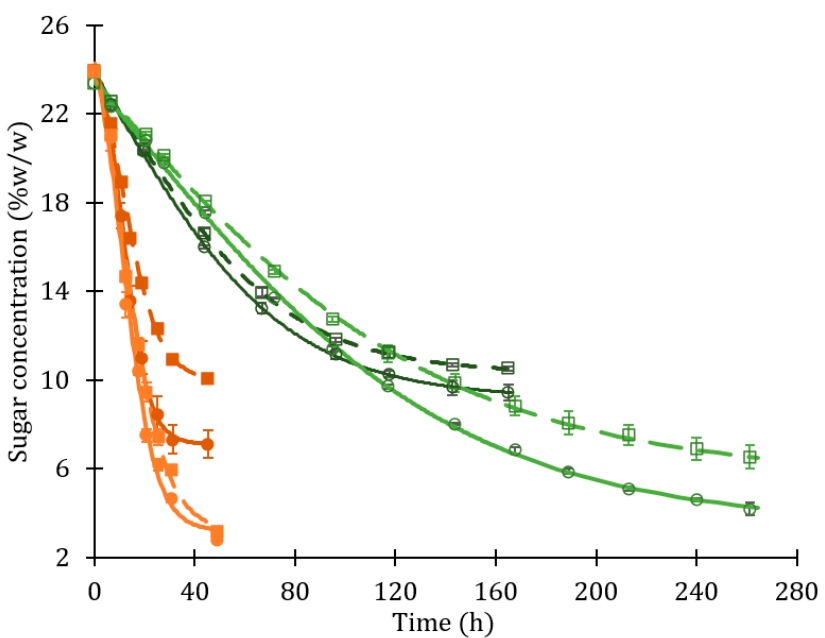
Figure 3. Sugar concentration during each fermentation configuration: LTHF (orange); HTHF (dark orange); LTLF (green); HTLF (dark green). Fermentations were performed in duplicate. Models were obtained using a Logistic 4P model, with a 95% confidence interval and the error bars represent the standard deviation of the data. The data shown represent sugar concentration under vacuum (circles) and atmospheric conditions (squares); sugar concentration model under vacuum (continuous lines) and atmospheric pressure (dotted lines).